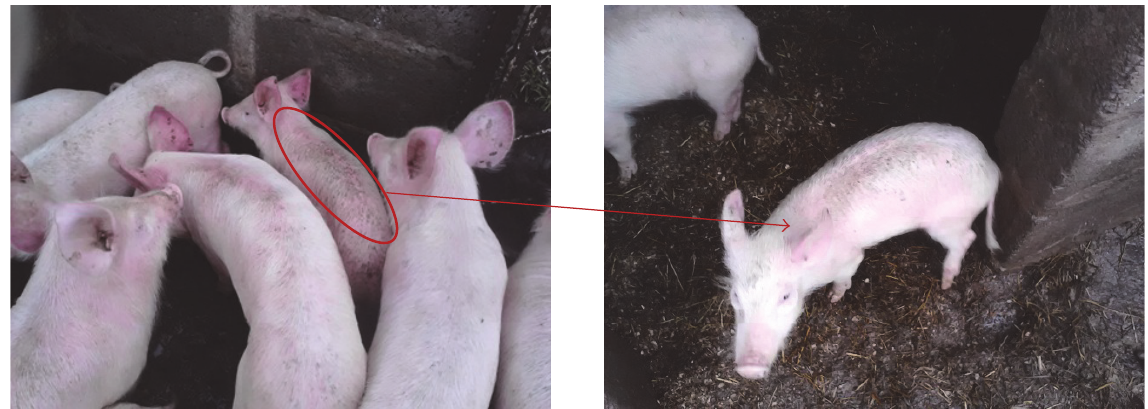
Figure3:WastingappearanceofapigwithanotablerespiratorydistresswithinaherdofthesameageatafarminLukhanjiLocalMunicipality, Chris-Hani District, Eastern Cape, South Africa (Picture taken in April, 2016 during a sampling